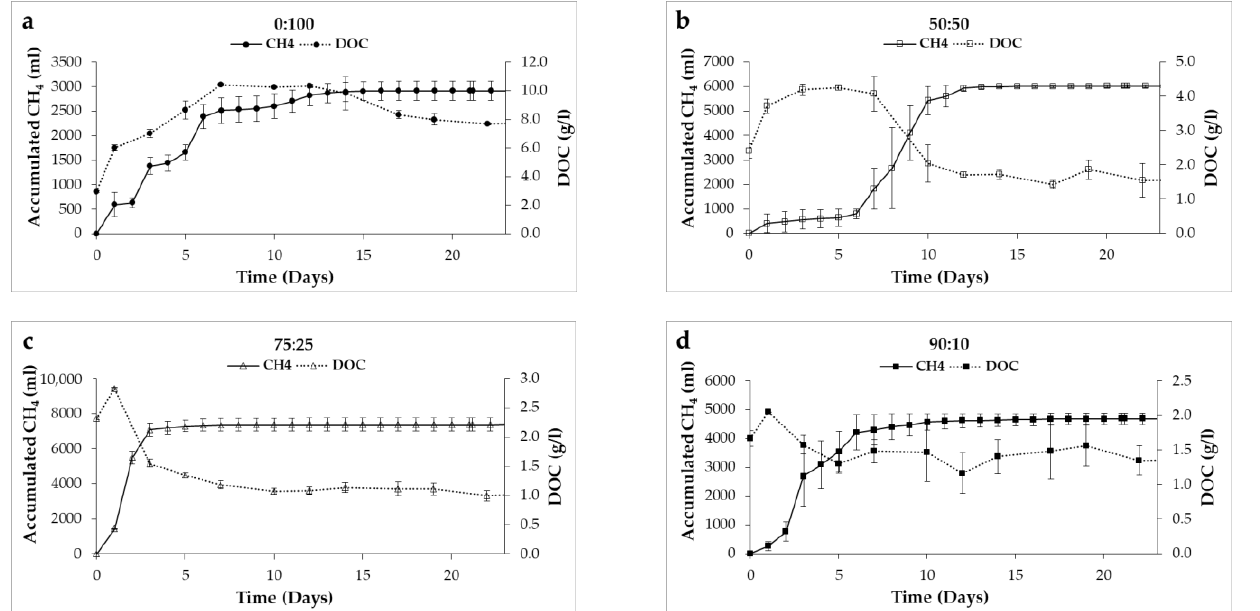
Figure 6. Comparison of the Dissolved Organic Carbon (DOC) and methane accumulation evolutions in the studied mixtures. ( a ): 0:100 mixture ratio; ( b ): 50:50 mixture ratio; ( c ): 75:25 mixture ratio; ( d ): 90:10 mixture ratio